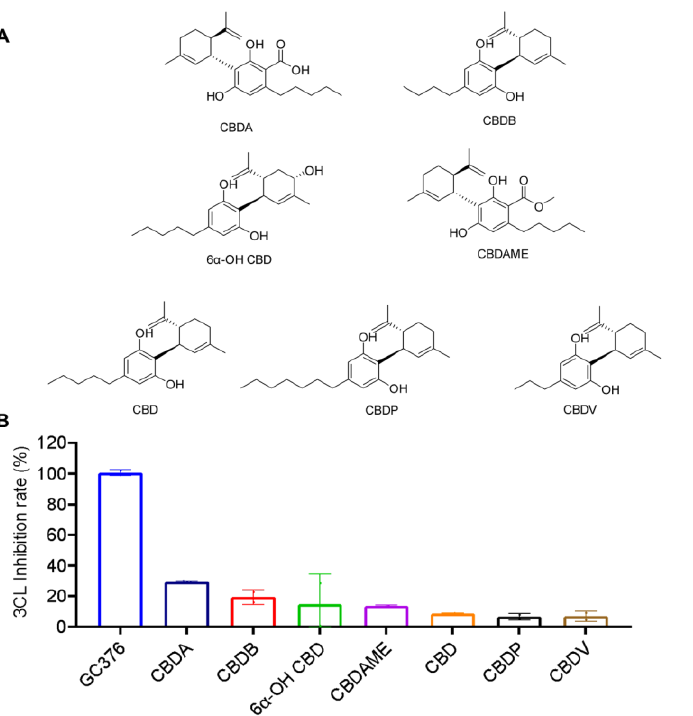
Figure 3. The chemical structures of the CBD-type of cannabinoids ( A ) and their inhibitory effect on the activity of SARS-CoV-2 M pro ( B ). These cannabinoids were tested at a concentration of 10 μM with the MBP-tagged SARS-CoV-2 M pro inhibition assay. GC376 was used as the positive control and each test compound was assayed in triplicates.